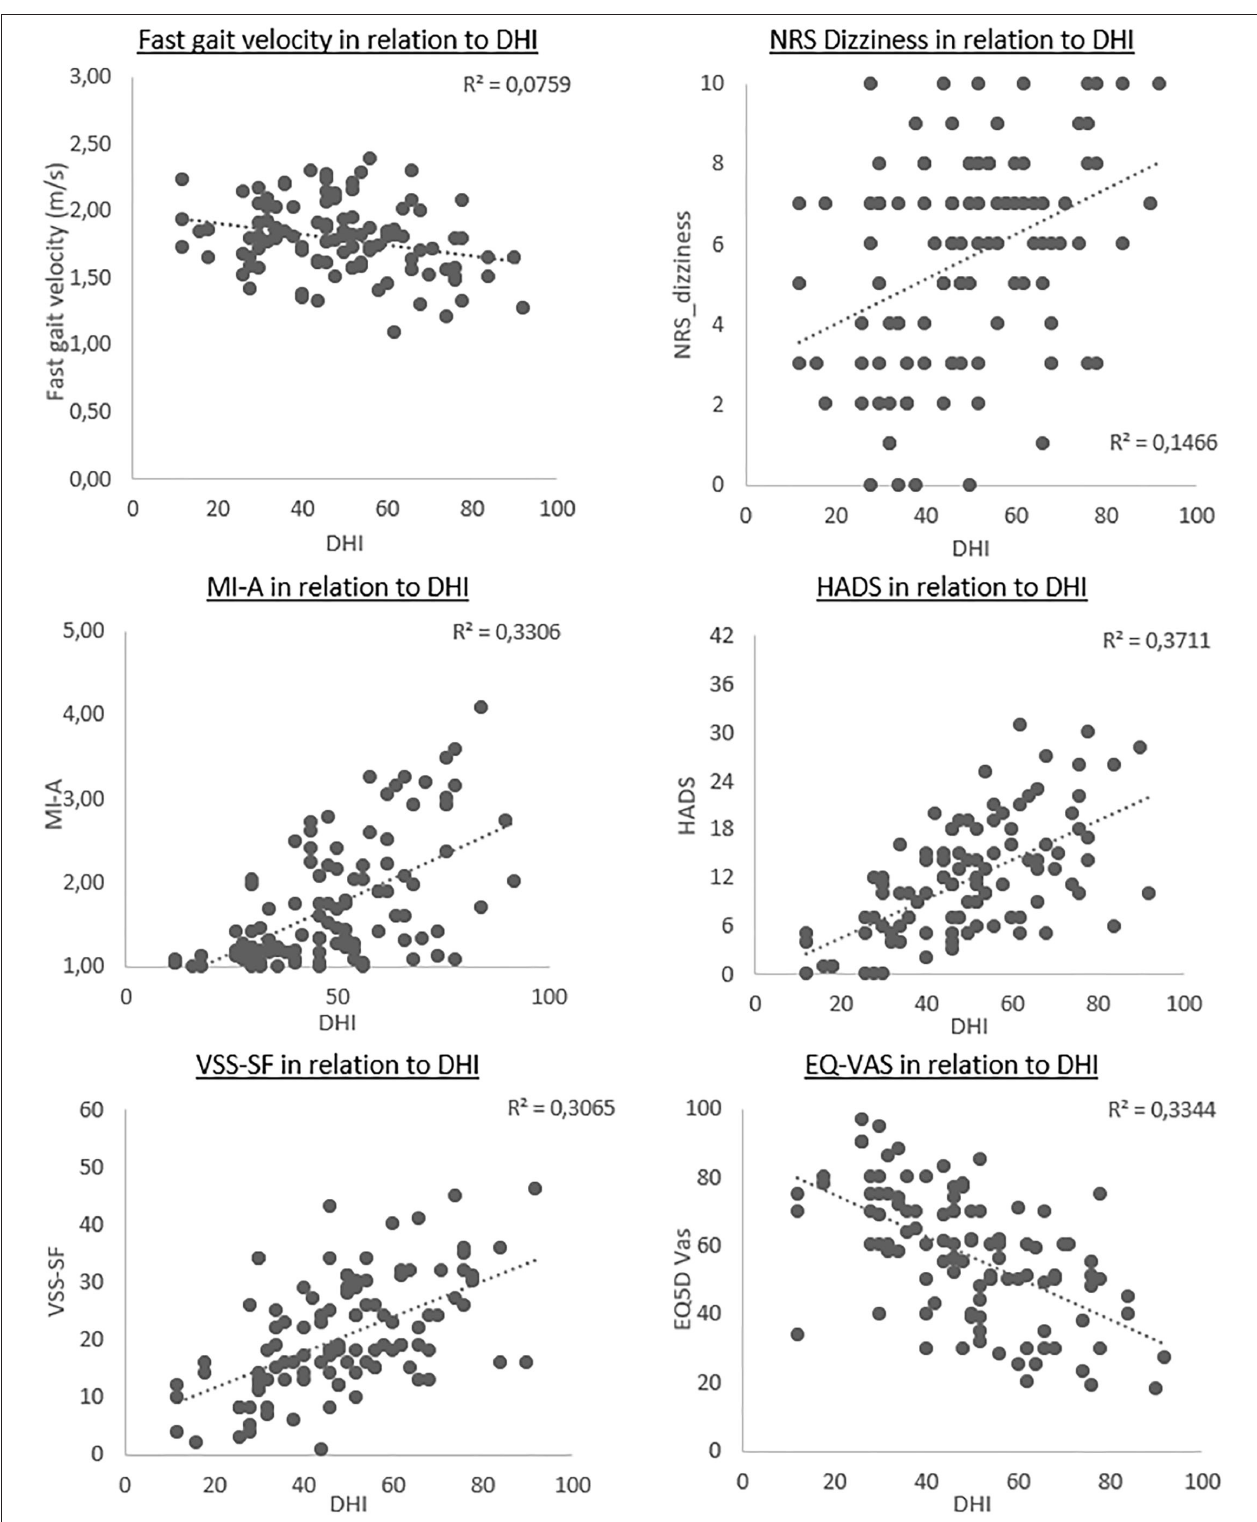
FIGURE 1 | Scatterplots of the outcomes significantly associated with the total Dizziness Handicap Inventory (DHI) score, in particicpants with persistent dizziness. Each plot presents the strength of the linear relationship, with DHI scores along x -axis and the different outcome measures on the y -axis. The dotted line represents the unadjusted regression coefficient for each